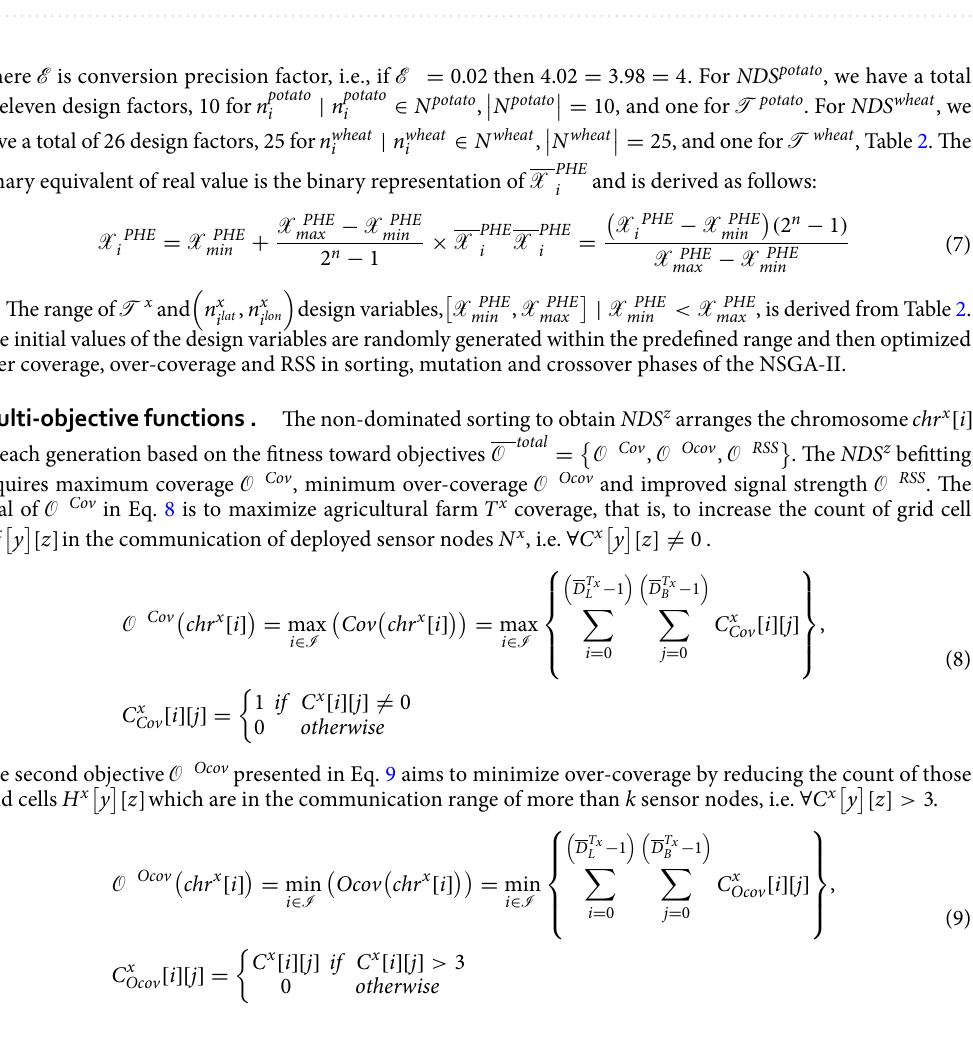
Figure 3. Proposed NSGA-II optimized node deployment strategy